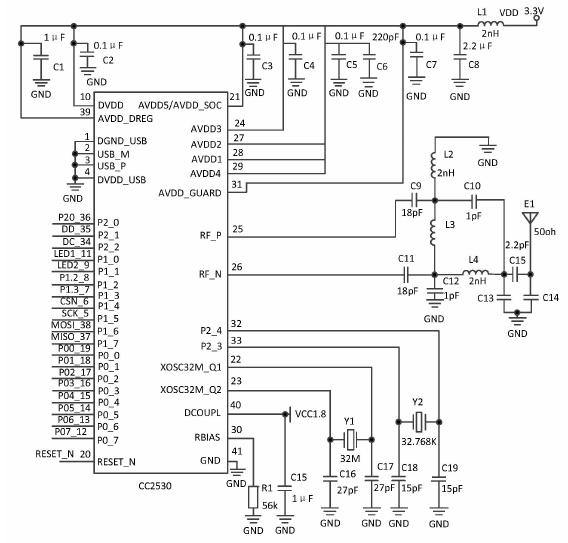
Figure 5. CC2530 schematic diagram.